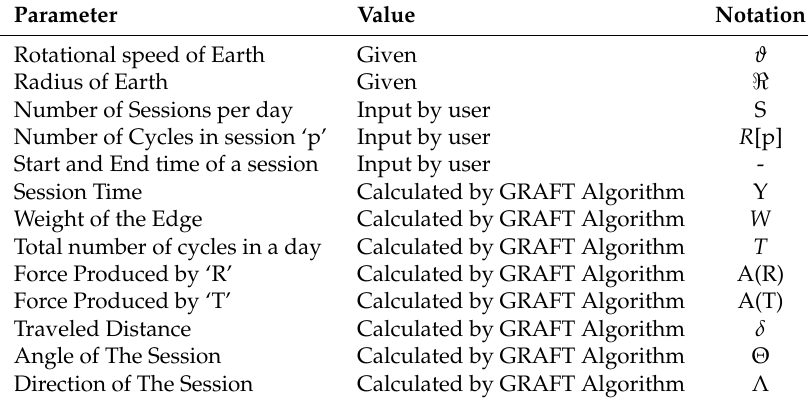
Table 1. Parameters used in the GRAFT model and their representative